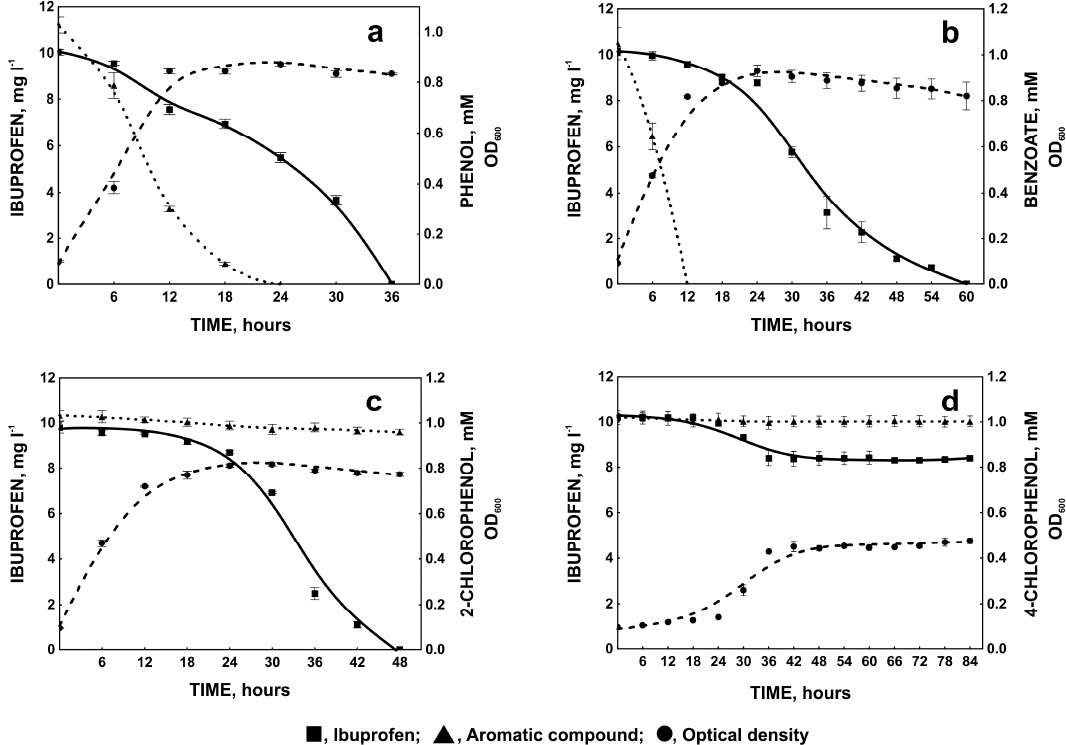
Figure 5. Biodegradation of ibuprofen by Bacillus thuringiensis B1(2015b), changes in optical density and degradation of phenol ( a ), benzoate ( b ); 2-chlorophenol ( c ); or 4-chlorophenol ( d ). The data points represent the average of three independent experiments.